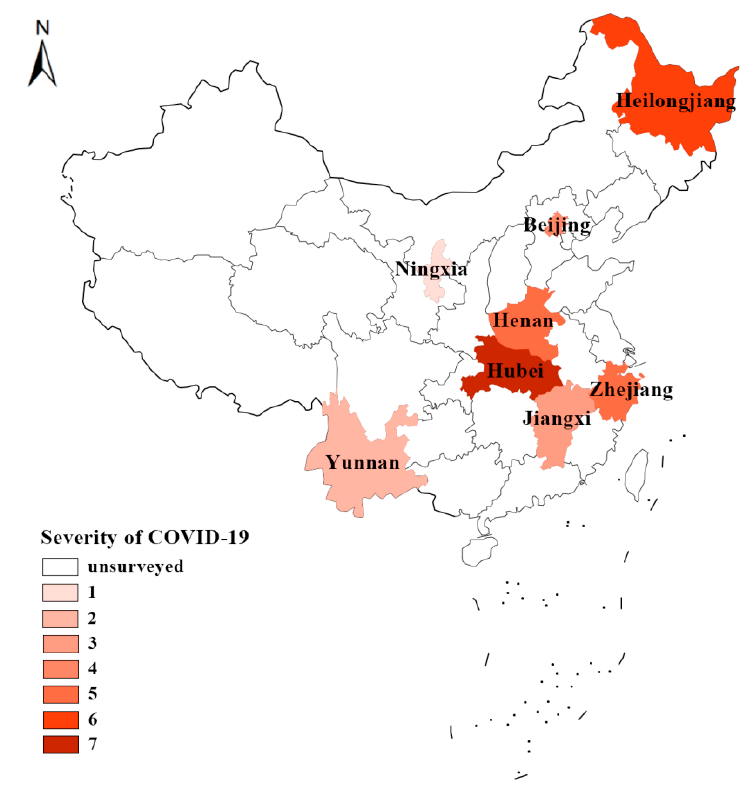
Figure 2. Distribution of surveyed provinces.